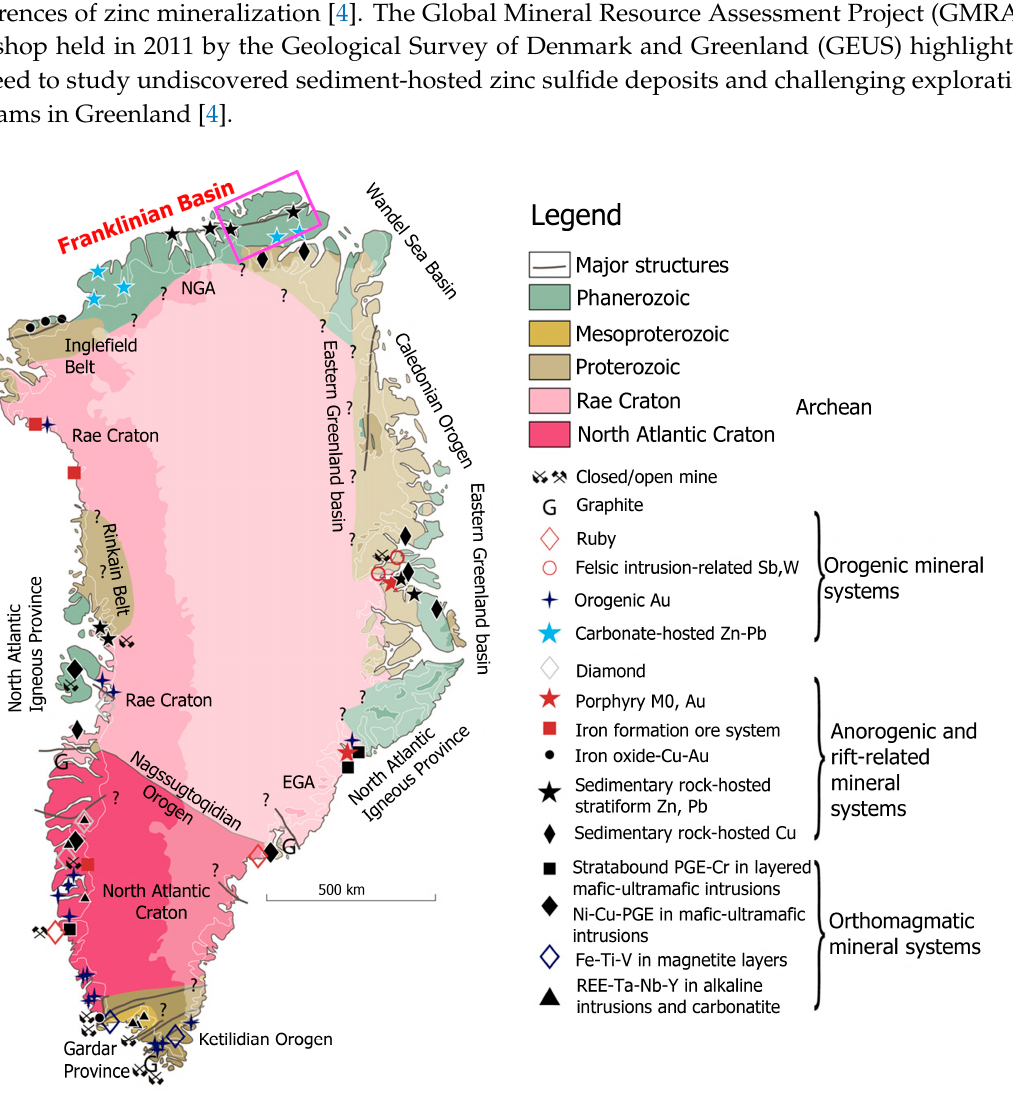
Figure 1. Geological map of Greenland showing the locations of different types of mineralization (modified from [2,3]). The magenta rectangle locates the area of the study.